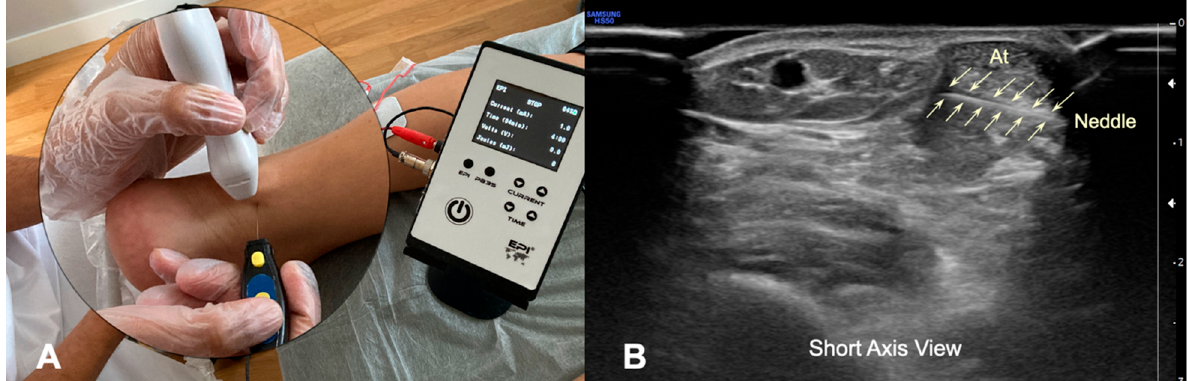
Figure 3. ( A ) Illustration of the percutaneous electrolysis approach at the Kager’s fat–Achilles ten- don interphase (from medial border). ( B ) Ultrasound imaging of the needle reaching the interphase of the Kager’s